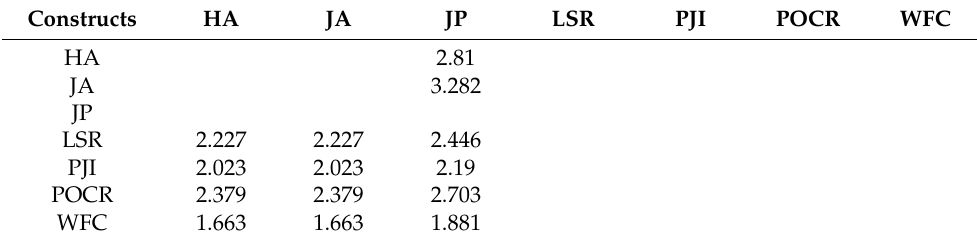
Table 6. Variance influence factor.